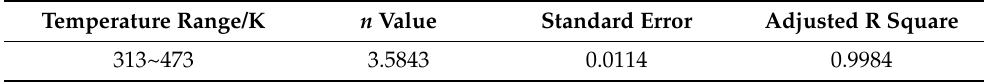
Table 1. n values in the temperature range of testo 882 infrared thermal imager